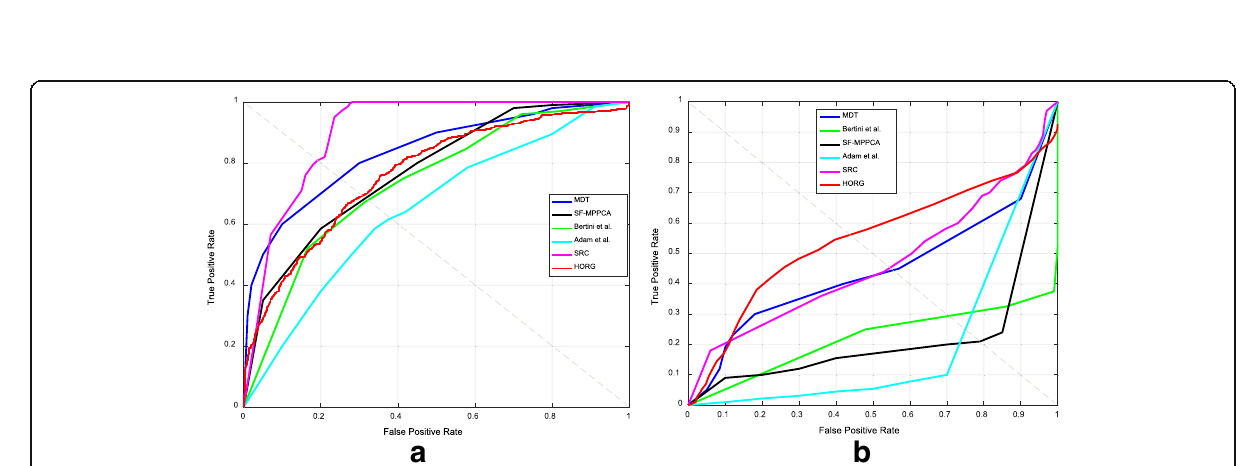
a b Fig. 5 Quantitative comparison of the detection results in the Ped1 dataset using ROC curves for the ( a ) frame-level criterion and ( b ) pixel-level